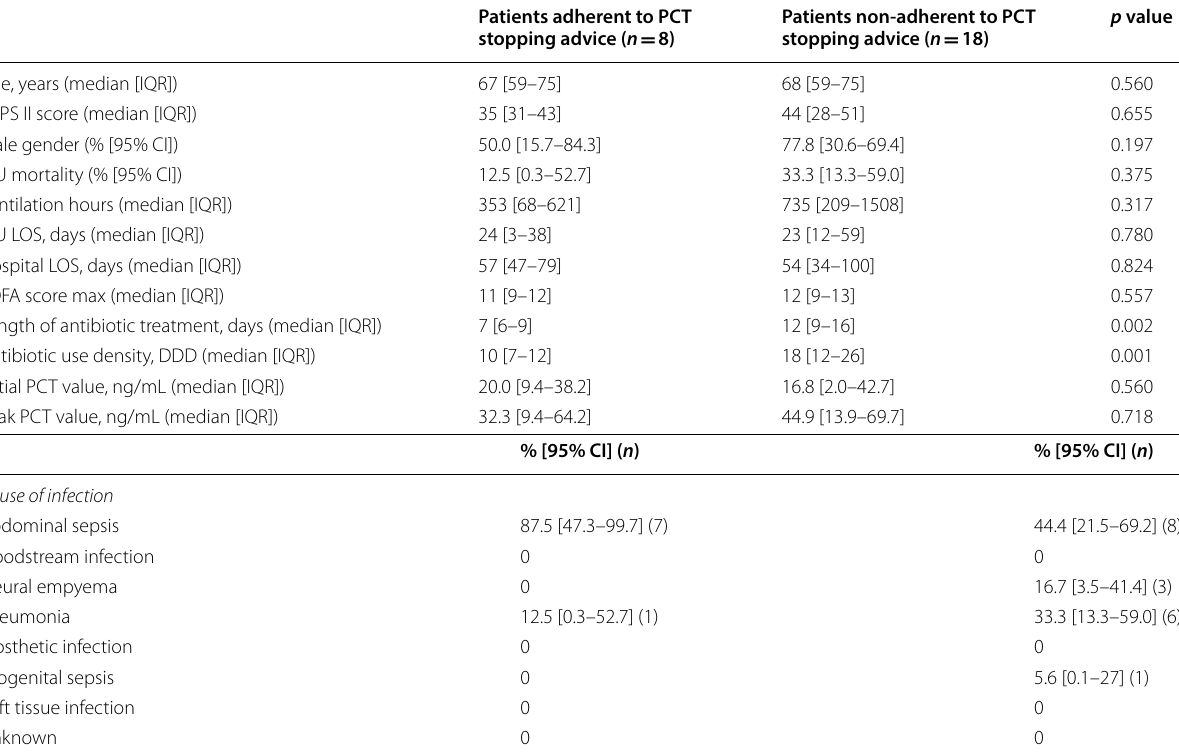
Table 3 Demographics and clinical data of patients with procalcitonin (PCT) stopping advice treated adherently and non-adherently to the PCT